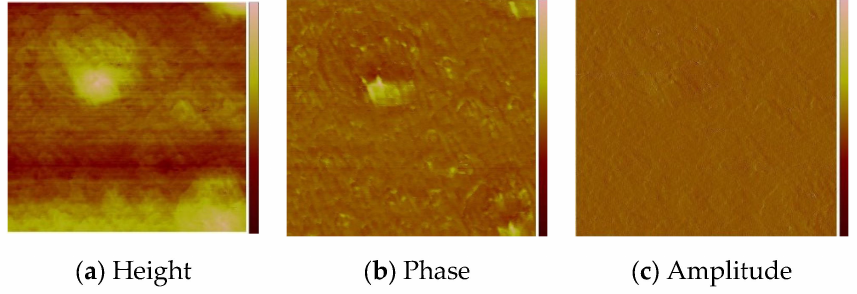
Figure 10. AFM of L1 /Si; 3000 rpm, 5s × 10, scan size 1 µ m, R a = 0.62 nm, R q = 0.99